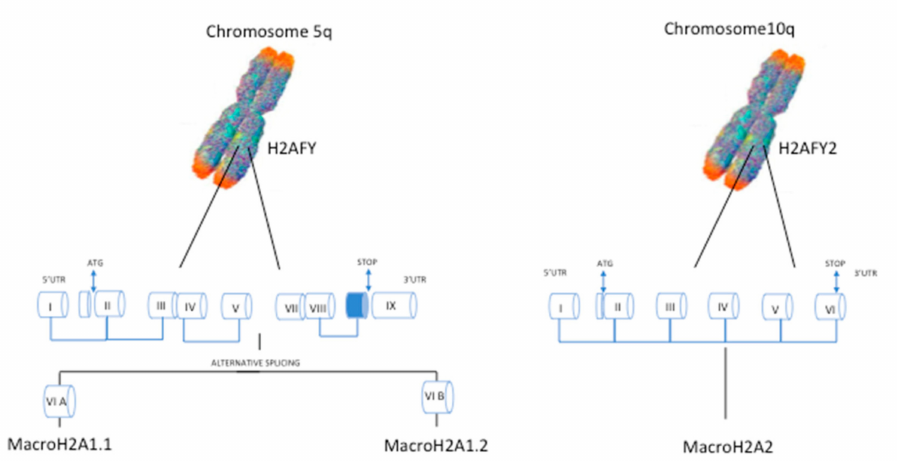
Figure 1. Representation of the chromosomal location of macroH2A1 and macroH2A2 genes in humans, and the organization of exons in the gene bodies. MacroH2A1 mRNA gives rise to two alternatively spliced isoforms, macroH2A1.1 and